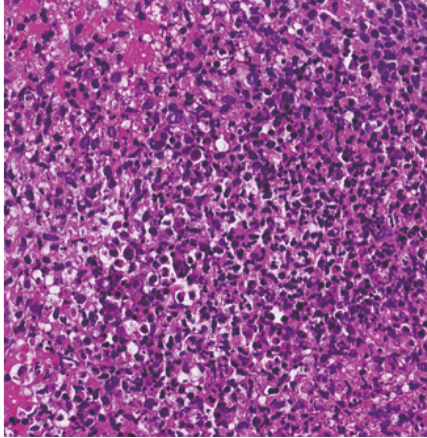
Figure 4: Histology: chronic-active inflammation with many plasma cells and eosinophilic